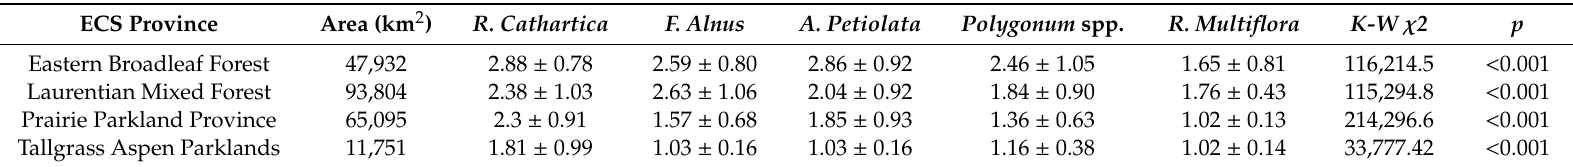
Table 3. Distribution of priority classes across Minnesota Ecological Classification System (ECS) Provinces for each species. Priority classes correspond to very low = 1, low = 2, medium = 3, and high = 4. Values ± 1 standard deviation.